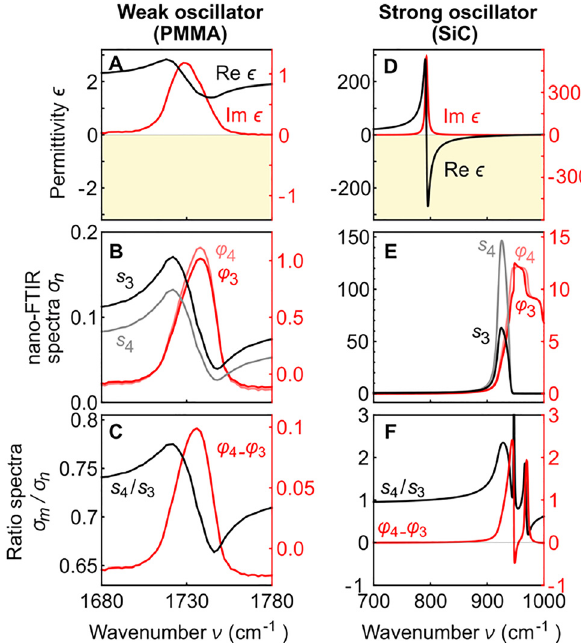
Figure 7: Comparison of calculated nano-FTIR spectra and their ratios for weak and strong oscillator